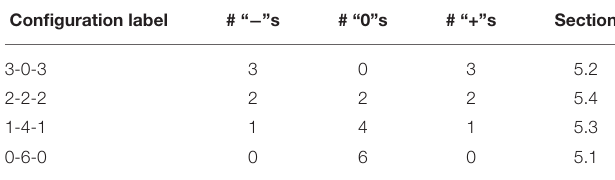
TABLE 1 | The four classes of sign configurations. Configuration